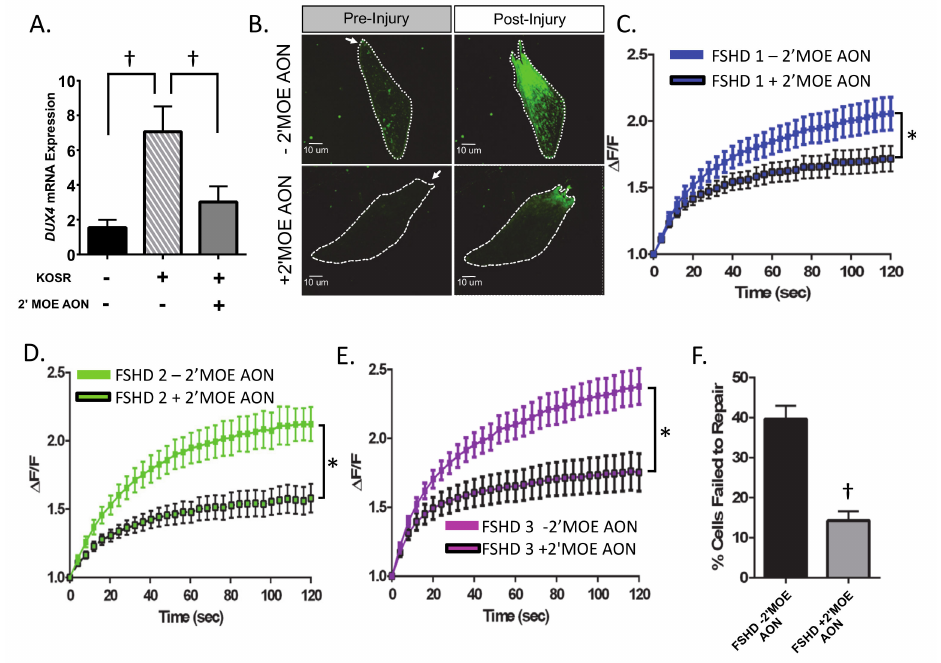
Figure 2. Treatment of FSHD-immortalized myoblasts with antisense oligonucleotides (2 (cid:48) -O-(2- Methoxyethyl)-oligoribonucleotide (2 (cid:48) MOE AON)) targeting DUX4 improves membrane repair. ( A ) The culturing protocol (three days in LHCN –DEX, three days in 15% KOSR media) significantly increases DUX4 mRNA expression in FSHD muscle cells. 2 (cid:48) MOE AON treatment reduces DUX4 mRNA to baseline levels ( n = 3 per cell line). ( B ) Images of FM1-43 dye entry in injured myoblasts at baseline (pre-injury) and at 120 s post-injury in control FSHD myoblasts, and FSHD myoblasts treated with 100 nM 2 (cid:48) MOE AON. Arrow indicates location of laser injury. ( C – E ) Change in intracellular FM1-43 dye fluorescent intensity ( ∆ F / F) over time for control FSHD myoblasts (FSHD1 n = 41 cells, FSHD2 n = 22 cells, FSHD3 n = 37 cells) and FSHD myoblasts treated with 100 nM 2 (cid:48) MOE AON (FSHD1 n = 39 cells, FSHD2 n = 22 cells, FSHD3 n = 33 cells). For all three cell lines, 2 (cid:48) MOE AON treatment significantly improves membrane repair (demonstrated by a significant reduction in dye entry post-injury) ( p < 0.05). ( F ) Percentage of cells that failed to repair with and without 2 (cid:48) MOE AON treatment across all three cell lines in each condition. Greater dye entry indicates worse repair. Values are mean ± SEM. * indicates significant treatment ( + 2 (cid:48) MOE AON vs. –2 (cid:48) MOE AON)*time interaction for FM1-43 intensity at p < 0.05. † denotes di ff erence between FSHD myoblasts treated with and without 2 (cid:48) MOE AON, paired t -test, p < 0.05. KOSR = knock-out serum